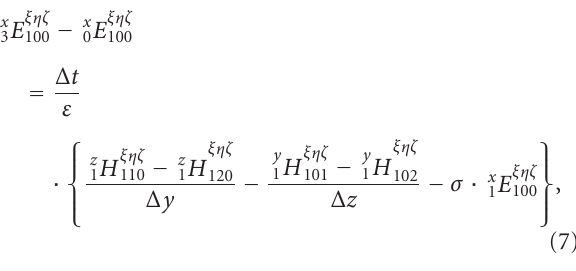
(cid:19) where b ( i ) = ( ∂ψ ( x ) /∂x ) ψ ( x + i − 1 / 2) dx are the MRTD coe ffi